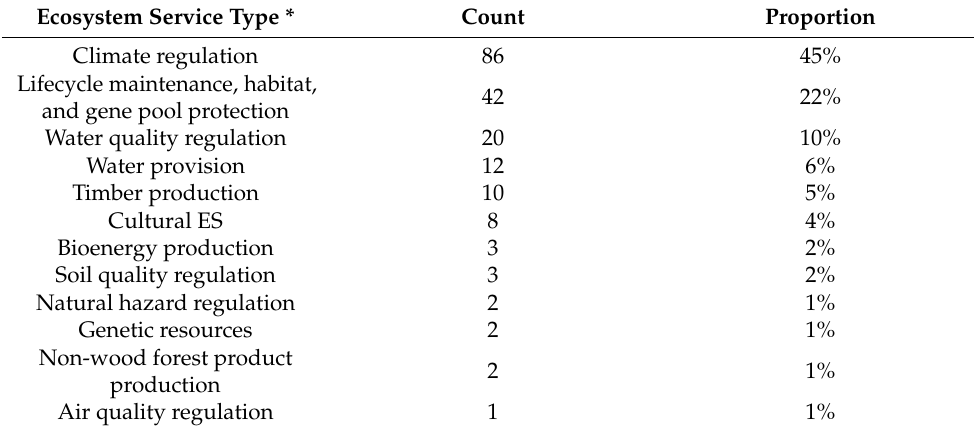
Table 1. Ecosystem service types, counts, and their proportions out of the total counts (proportion represents the mechanisms that have this type of ES account for the total mechanisms). Ecosystem Service Type *